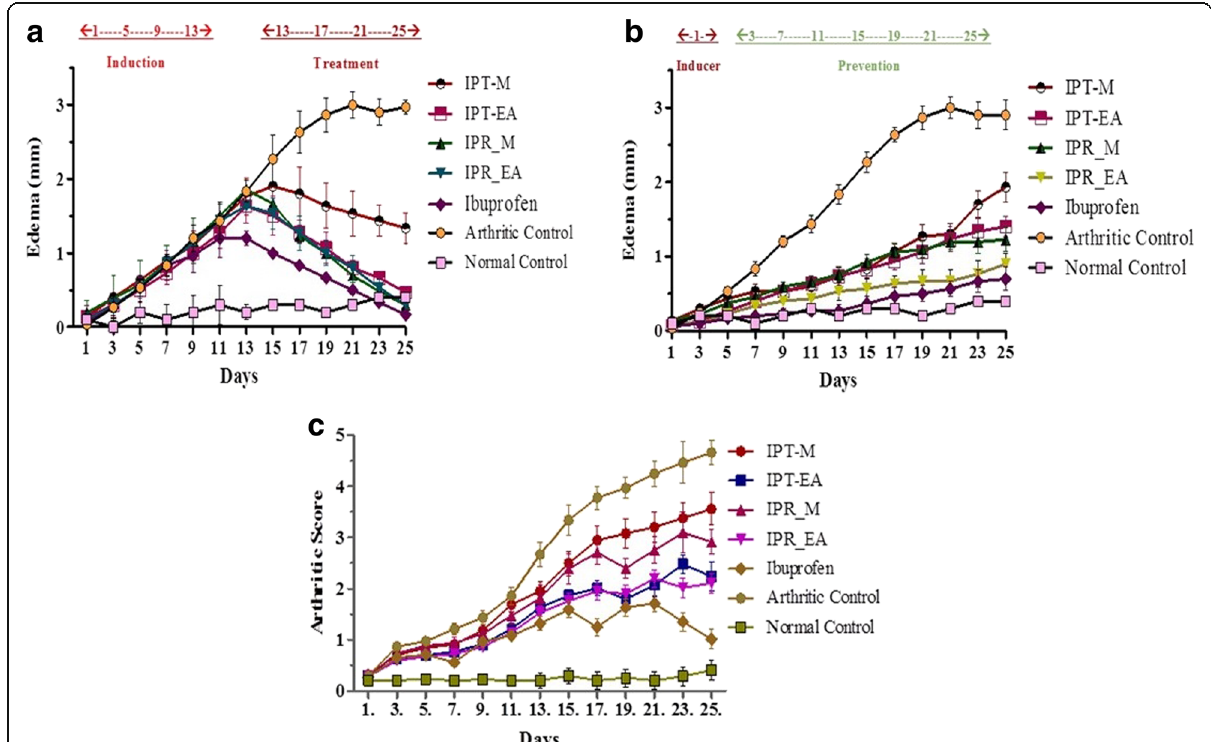
Fig. 5 Assessment of arthritic edema and arthritic score. Data is presented as the mean arthritic score ± SEM ( n = 6/group). a Treatment mode of studies where the induction was done till day 13 and then dose was started. Edema in arthritic control group increased with the passage of time. IPR-EA and IPR-M have significantly decreased arthritic edema after 15th day in comparison to ibuprofen. b Preventive mode of study where dose was given after inducer at day 1. Arthritic control group has not prevented the induction of the disease while IPR-EA and IPR-M have significantly prevented arthritic edema in comparison to ibuprofen. c Arthritic score where arthritic control group has higher arthritic score compared to normal and other groups. The ibuprofen treated animals showed significant decrease in arthritic score after first week